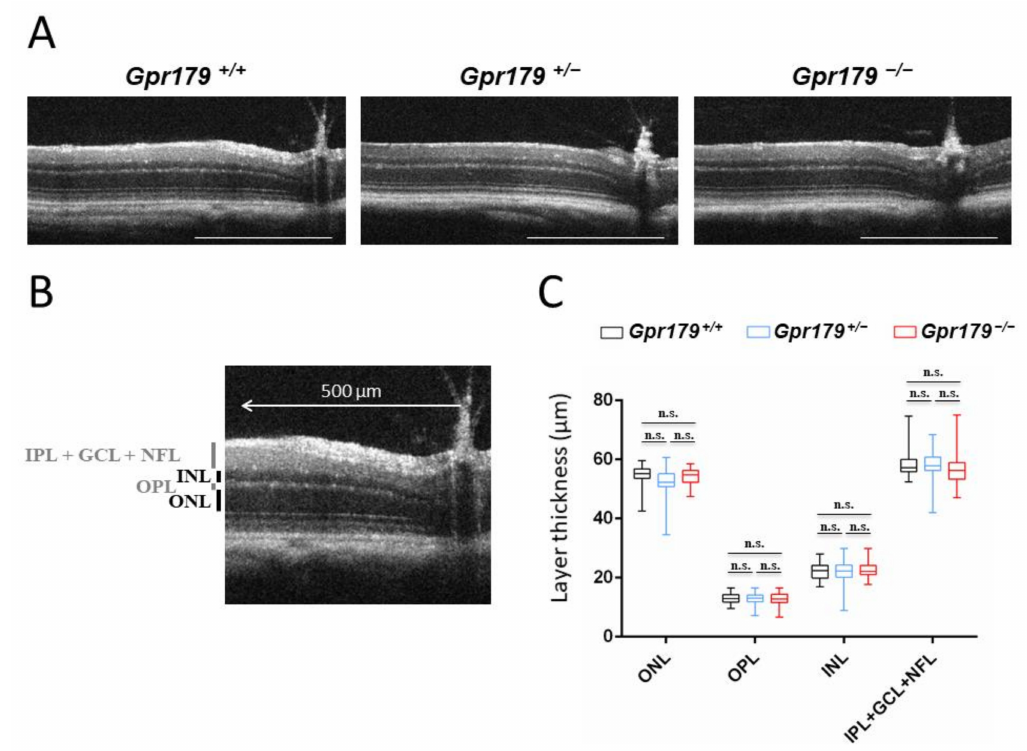
Figure 2. Spectral domain optical coherence tomography (SD-OCT) retinal morphology and layer thicknesses of 3-month-old Gpr179 +/+ , Gpr179 +/ − , and Gpr179 − / − mice. ( A ) Representative SD-OCT sections of 3-month-old Gpr179 +/+ , Gpr179 +/ − , and Gpr179 − / − mice. Scale bar: 500 µ m. ( B ) Outer nuclear layer (ONL), outer plexiform layer (OPL), inner nuclear layer (INL), a complex comprising inner plexiform layer (IPL), ganglion cell layer (GCL), and nerve fiber layer (NFL) called IPL+GCL+NFL are measured at 500 µ m of the optic nerve on SD-OCT images. ( C ) ONL, OPL, INL, and IPL + GCL + NFL thicknesses of 3-month-old Gpr179 +/+ (black box), Gpr179 +/ − (blue box), and Gpr179 − / − (red box) mice were compared. Error bars represent standard errors; n.s. indicates a non-significant test ( p >